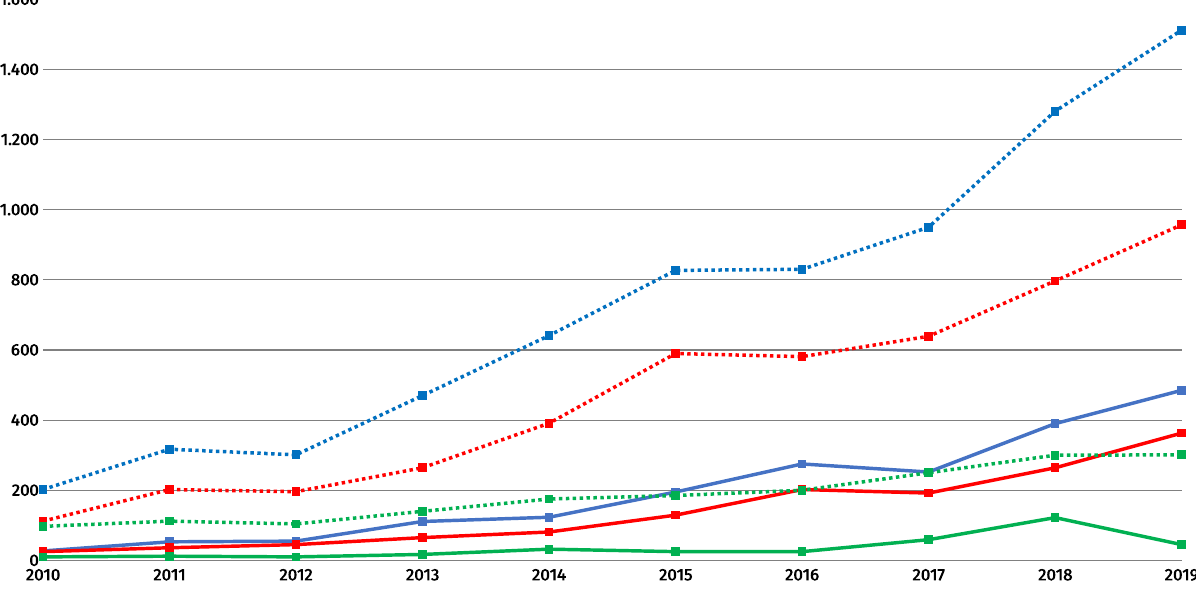
Figure 1. Graphs showing the evolution between 2010 and 2019 of the manuscripts received (in blue), rejected (in red), and published (in green) by the Annals of the Brazilian Academy of Sciences (AABC). Dotted lines represent manuscripts from all areas (including Agrarian Sciences), while solid lines represent Agrarian Sciences